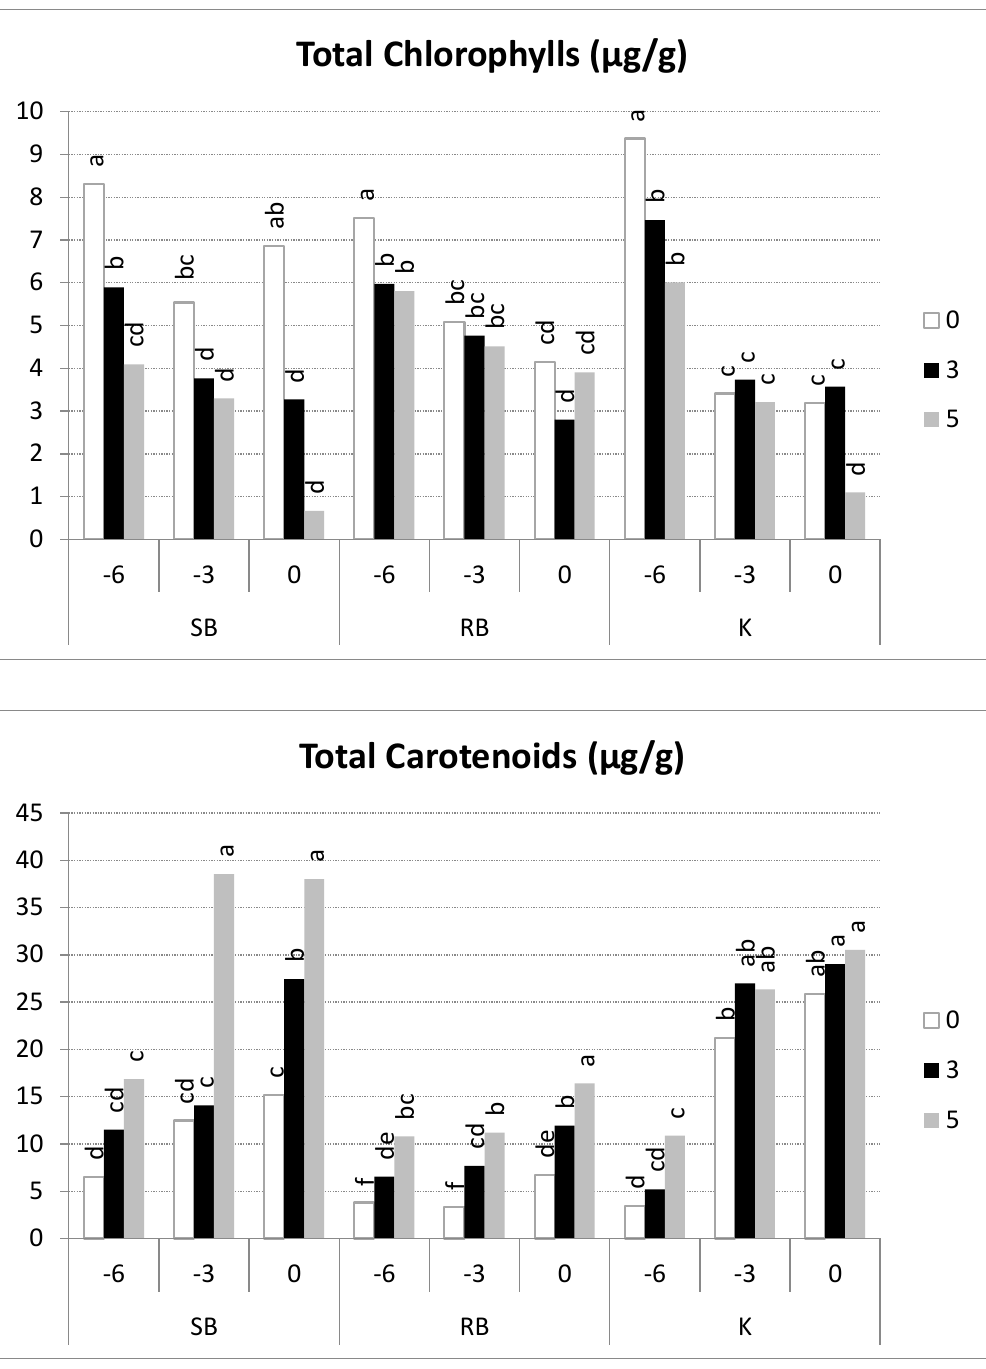
Figure 8. Apricot pigment (total chlorophyll and total carotenoids) evolution at harvest and during the shelf-life of apricot cultivars at all three harvest dates and subsequent shelf-life. Per cultivar, samples with different letters differ at a significance level of 0.05 according to Tukey’s test (n =